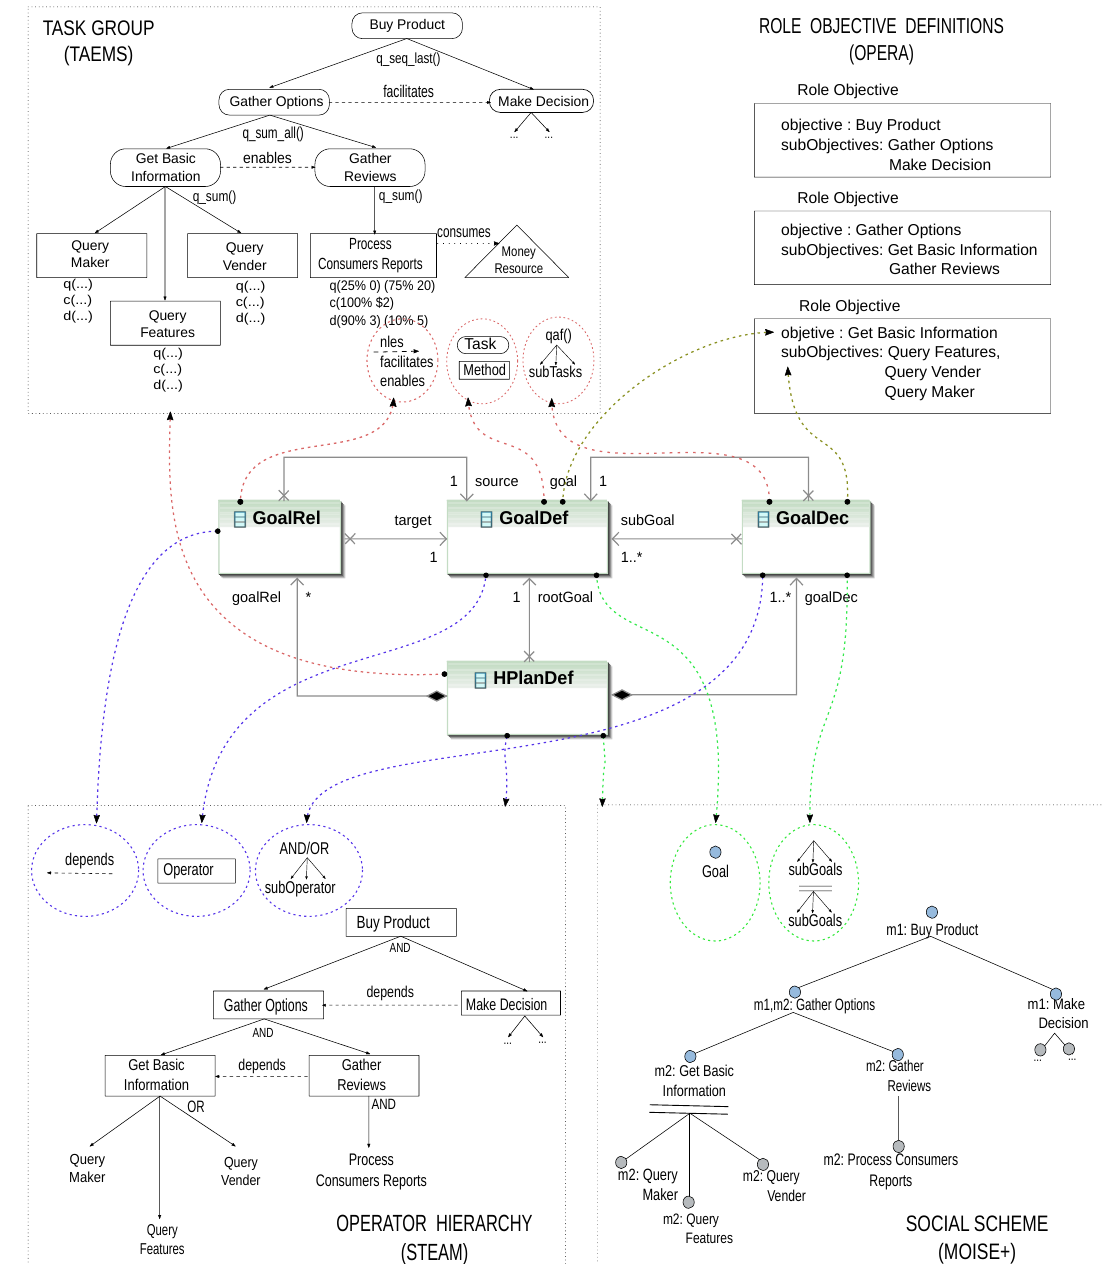
Figure 2. Similar functional specifications written in TAEMS, OPERA, STEAM and MOISE+, which prescribe how an agent is supposed to proceed for buying a product in an electronic market (example taken from [47]). The class diagram (Ecore metamodel) in the center of the figure represents the conceptual pattern identifiable in the various approaches of functional modeling. The dotted arrows detail what concepts are captured by what classes of the